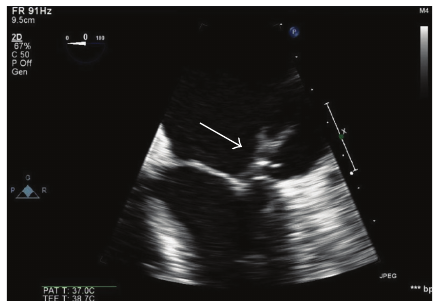
Figure 3: Atrial septal defect